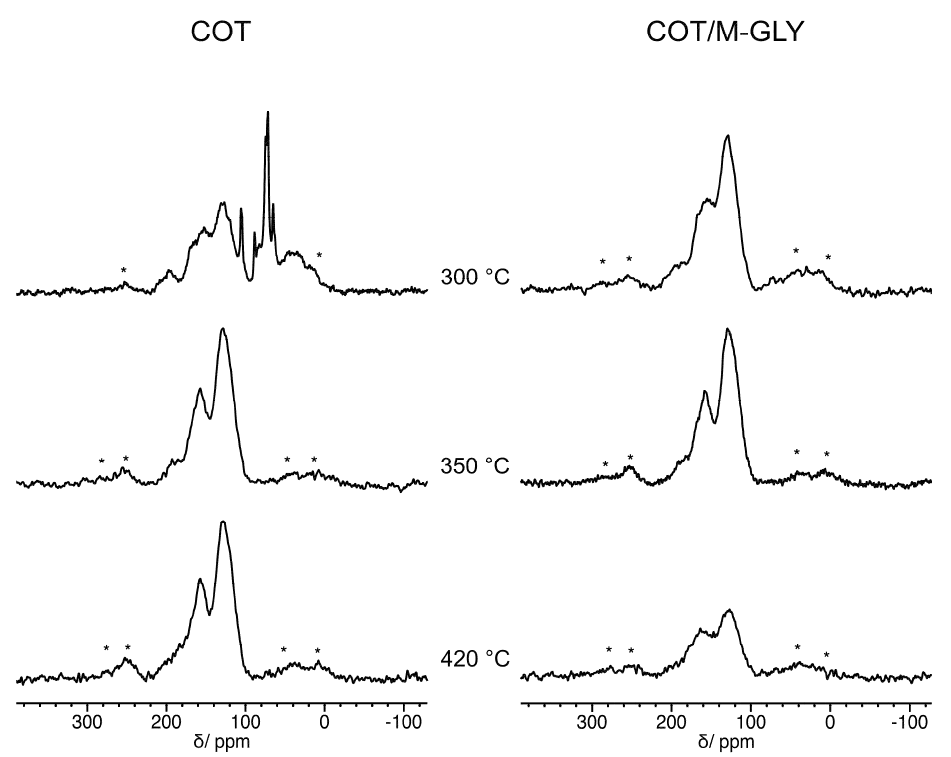
Figure 8. 13 C CP-MAS NMR spectra of residues of COT ( left ) and COT/M-GLY ( right ) after heating in air at 300 ◦ C, 350 ◦ C, and 420 ◦ C (from top to bottom ) recorded at a spinning frequency of 15 kHz. Asterisks indicate spinning sidebands.